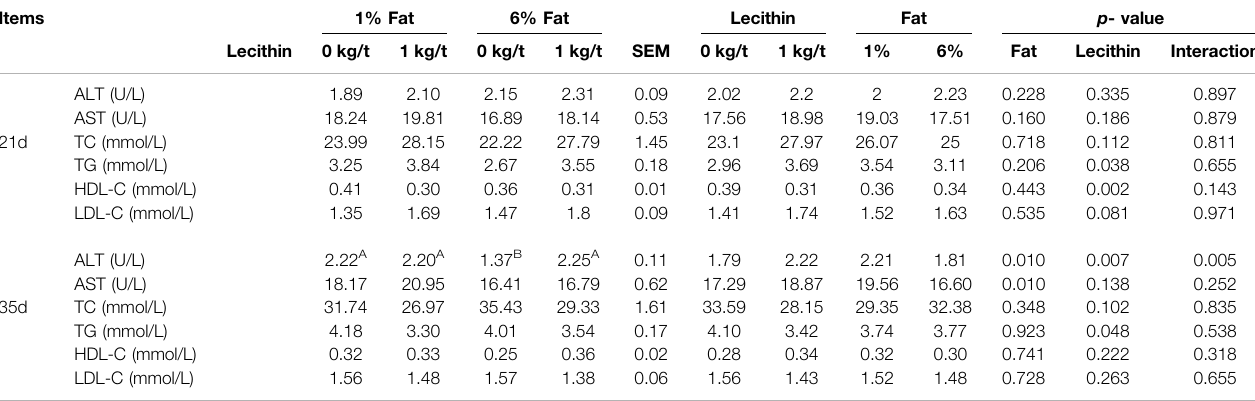
TABLE 3 | Effects of adding lecithin on serum biochemical indexes of laying hens. Items